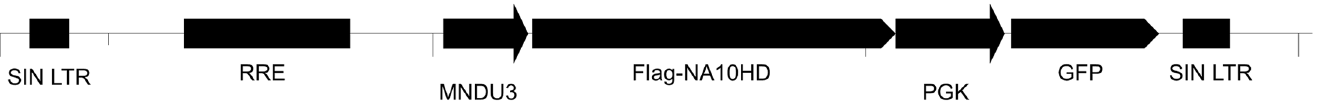
Fig 1. NUP98-HOXA10HD (NA10HD) lentiviral vector construct. Self inactivating lentiviral vector encoding (SIN LTR), rev responsive element (RRE), modified MLV long terminal repeat promoter (MNDU3), FLAG tagged NUP98-HOXA10HD (FLAG-NA10HD), mouse phosphoglycerate kinase promoter (PGK), enhanced green fluorescent protein